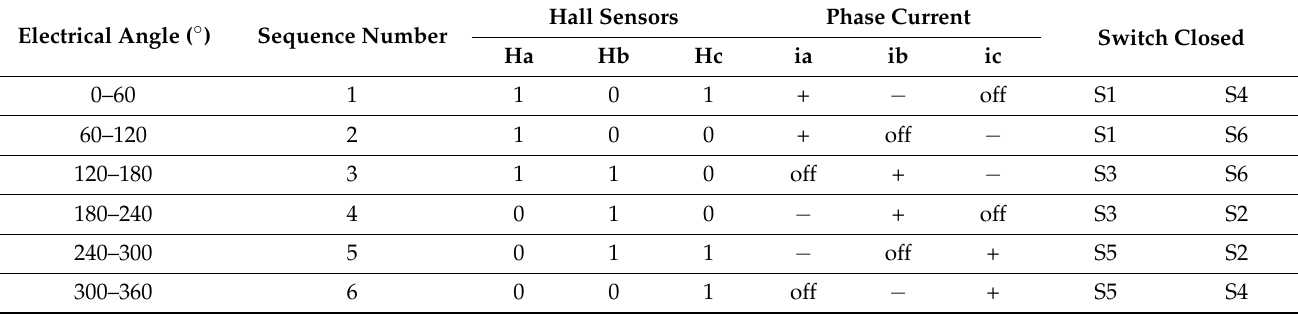
Table 5. Switching sequence by using Hall Effect sensor